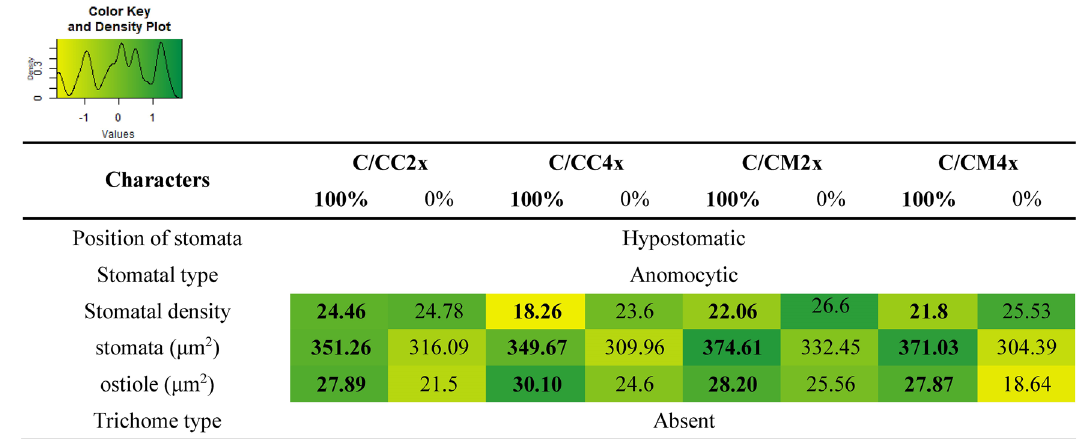
Table 2. Anatomy of the leaf epidermis of common clementine scion grafted onto different rootstock. Anatomical characters of leaves epidermis of common clementine scion grafted onto diploid (C/CC2x) and doubled diploid (C/CC4x) Carrizo citrange and diploid (C/CM2x) and doubled diploid (C/CM4x) Citrumelo 4475 rootstocks grown in nutrient reference solution (100%) and without nutrient solution (0%) for 210 days. For length and width of stomata and ostioles, values are means (± standard error) of 30 independent measurements on three different leaves ( n = 90). For stomatal density, values are means of five independent measurements on three different leaves ( n = 15) for stomatal density. The heatmap shows the differences between the four scion/rootstocks combinations and treatments for each characteristic. Values are associated with color ranging from yellow (low) to dark green